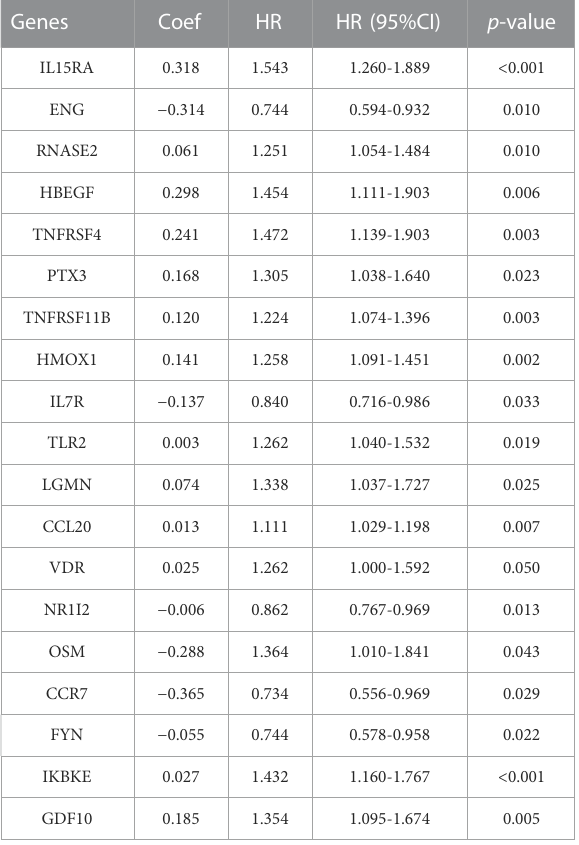
TABLE 1 Immune-associated signature